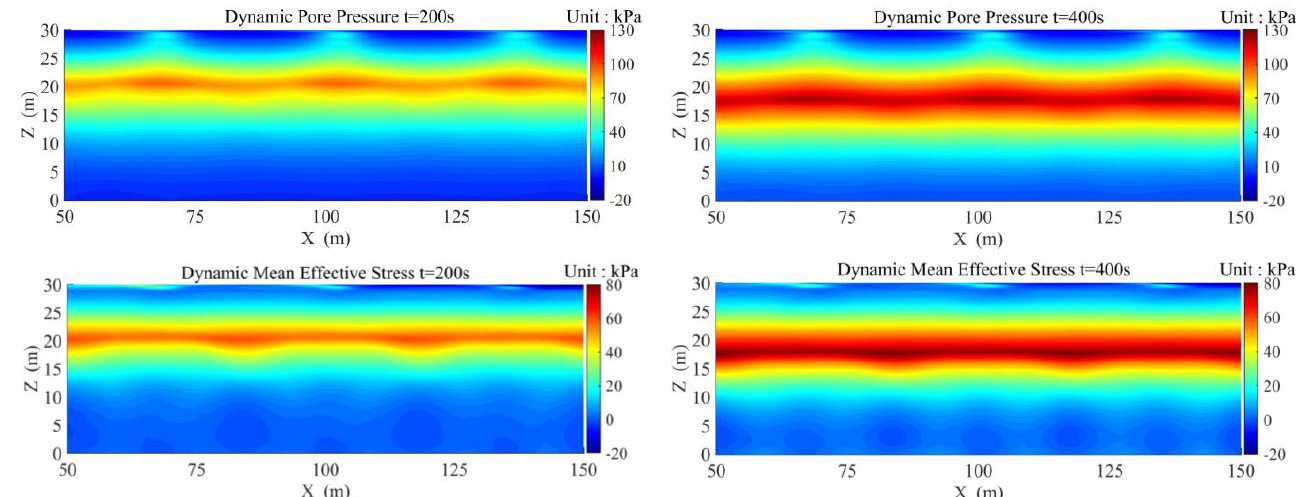
Figure 5. Distributions of dynamic pore pressure and mean effective stress at time t / T = 25 and t / T = 50.